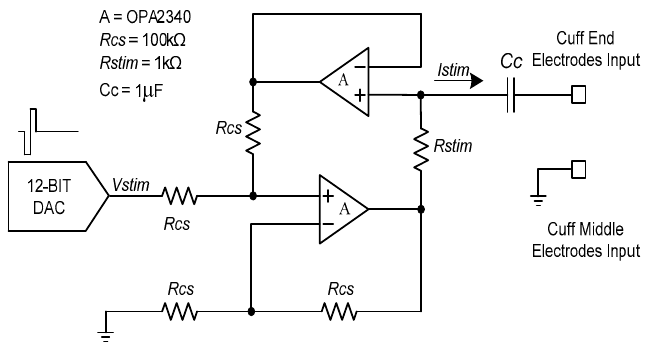
Figure 4. Block diagram of the proposed voltage-controlled current source.